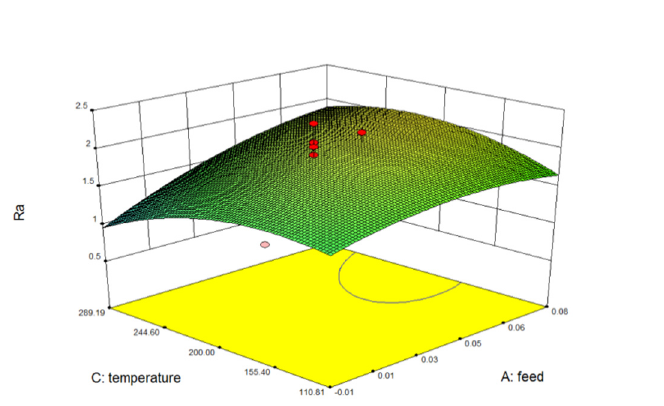
( b ) Figure 5. 3D surface plot and contour plot of R a for A and B: ( a ) 3D surface plot; ( b ) contour plot. The red dots in figure indicate the location of the center point in the experimental data distribution graph taken during the experimental design.